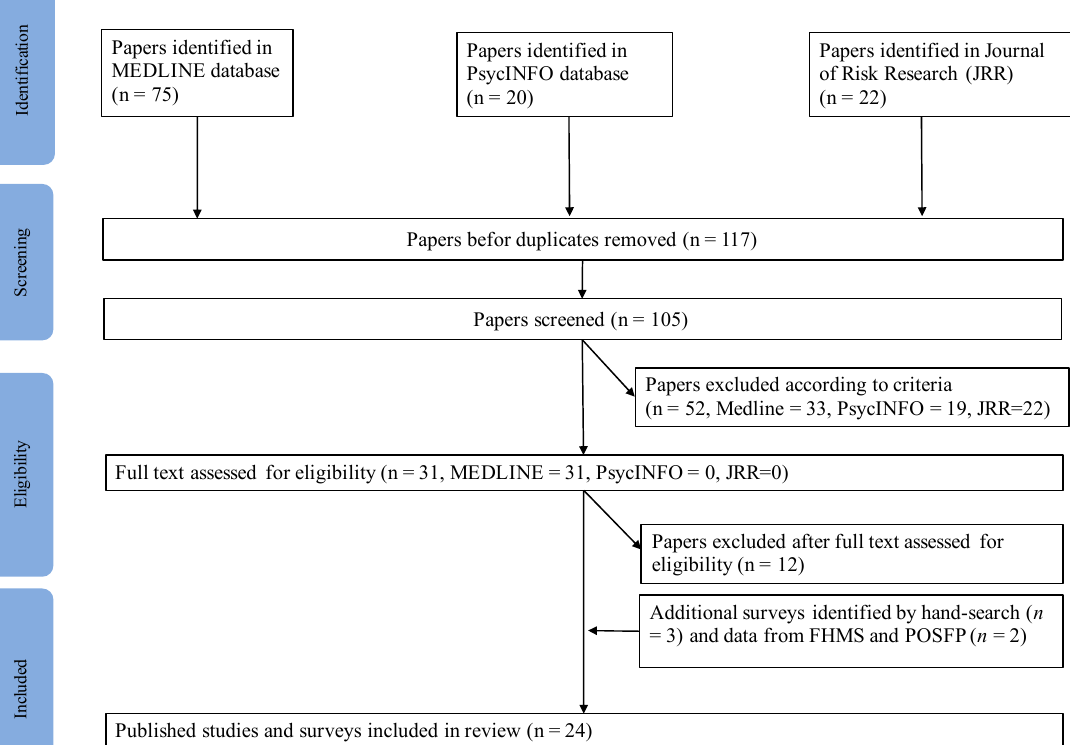
Figure 1. Flow diagram of study selection.